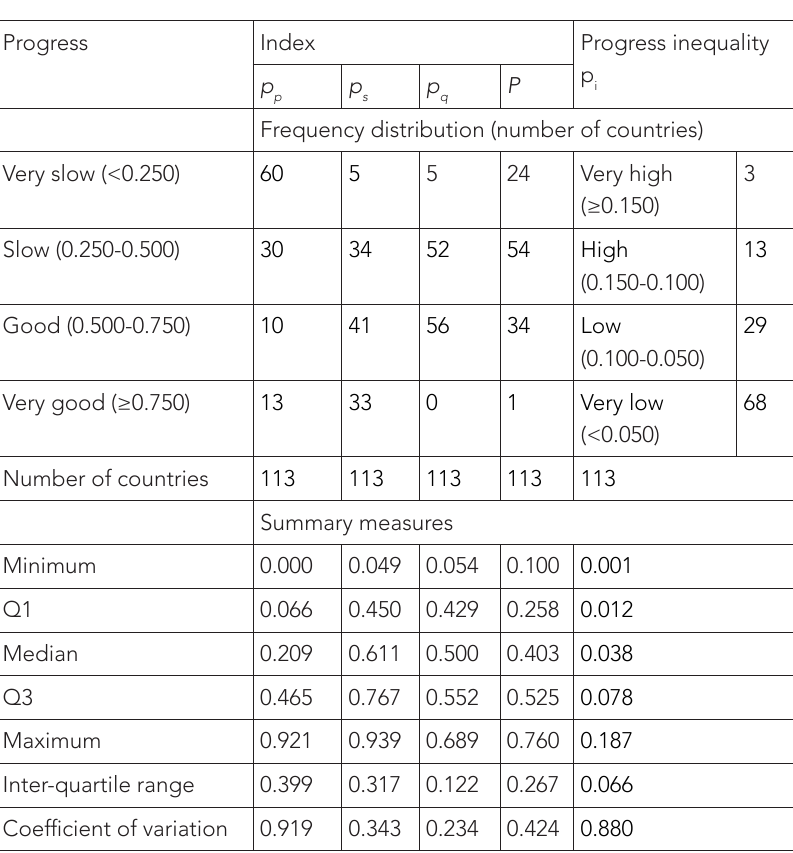
Table 1: Inter-country Distribution of Different Indicators of Family Planning